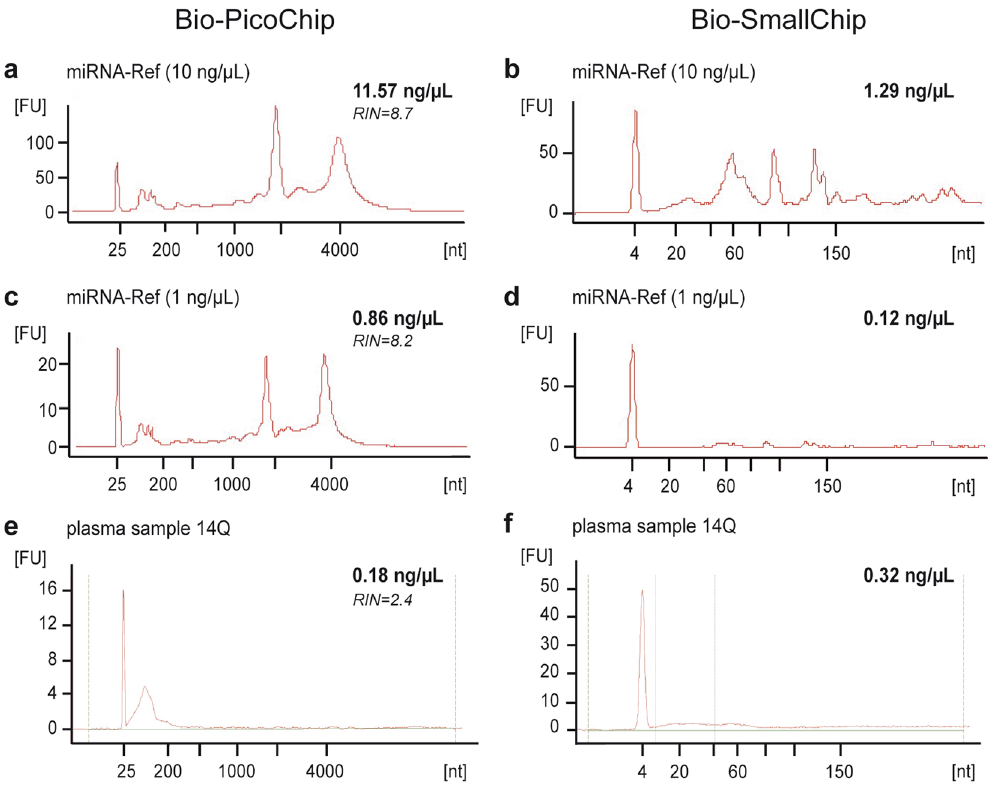
Figure 1. Electropherograms obtained with the Bioanalyzer 2100 in miRNA-Ref and plasma samples. Examples of the profiles obtained from a miRNA-Ref sample at 10 ng/ μ L ( a , Bio-PicoChip; ( b ), Bio-SmallChip), a miRNA-Ref sample at 1 ng/ μ L ( c , Bio-PicoChip; ( d ), Bio-SmallChip), and a plasma sample ( e , Bio-PicoChip; ( f ), Bio-SmallChip). The 10 ng/ µ L miRNA-Ref sample ( a ) was diluted to fit the detection range of the Bio- PicoChip (0.05–5 ng/ µ L) and the final concentration was calculated by applying the dilution factor to the value obtained by the Bioanalyzer. In the miRNA-Ref samples ( a – d ), the overall profile is consistent with the presence of ribosomic RNA enriched with small RNAs, whereas in plasma samples ( e , f ) only small RNAs, but no long RNAs, are present. All electropherograms include the corresponding quantification (in bold) and the RNA integrity number (RIN) number (in italics) obtained with the Bio-PicoChip ( a , c , e ) or just the quantification (in bold) with the Bio-SmallChip ( b , d , f